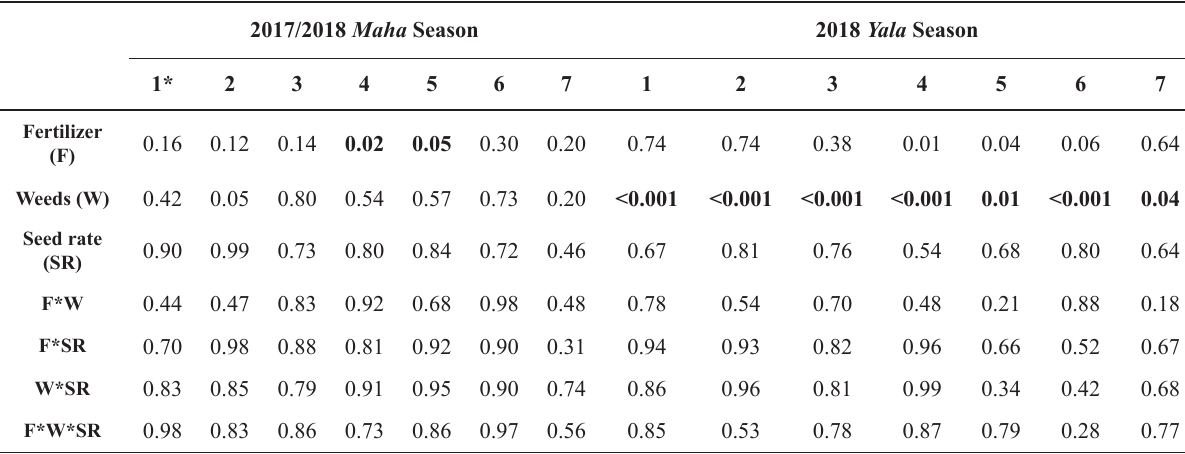
Table 1: Associated probability values for the effect of nitrogen fertilizer, weed control, and seed rate on the disease incidence index in the 2017/2018 Maha season, 2018 Yala